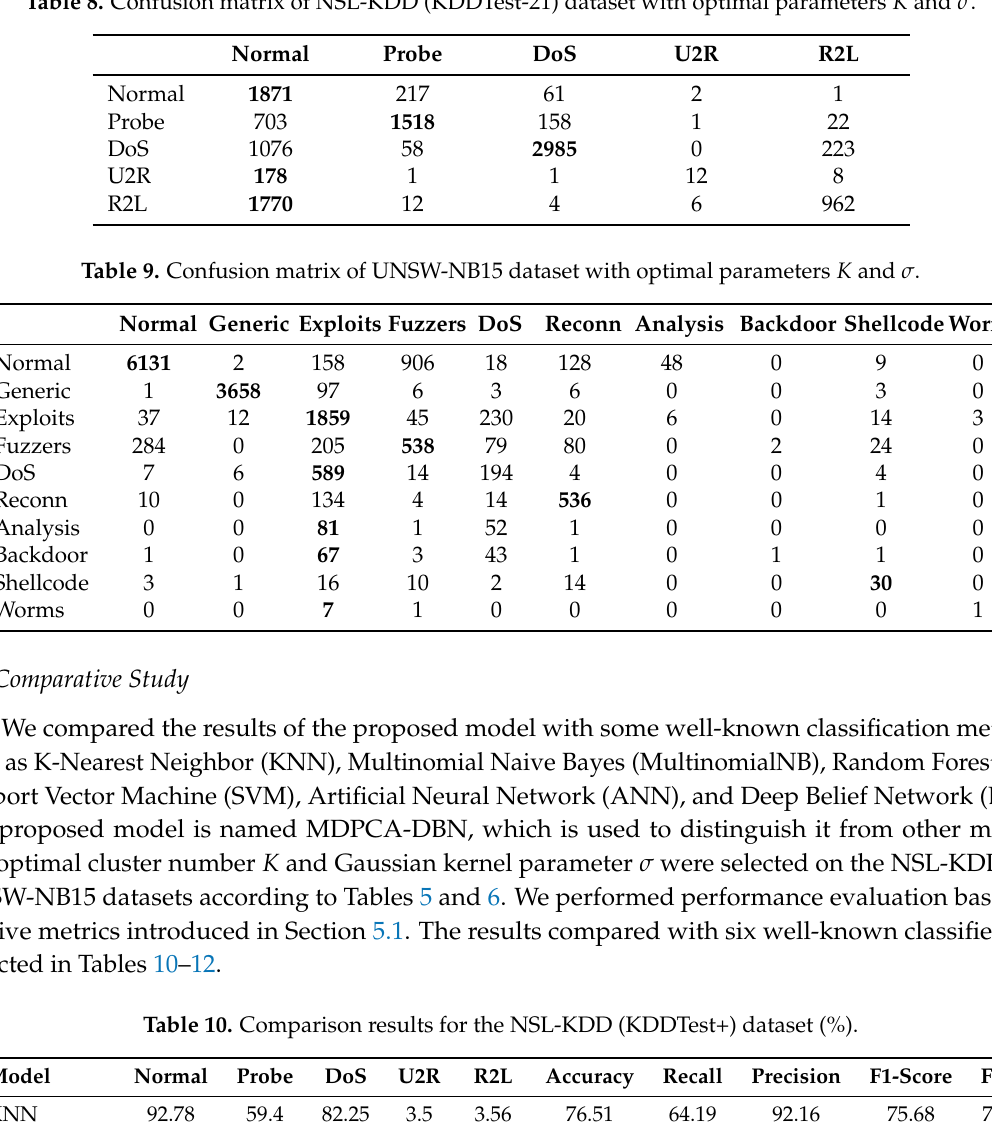
Table 8. Confusion matrix of NSL-KDD (KDDTest-21) dataset with optimal parameters K and σ .